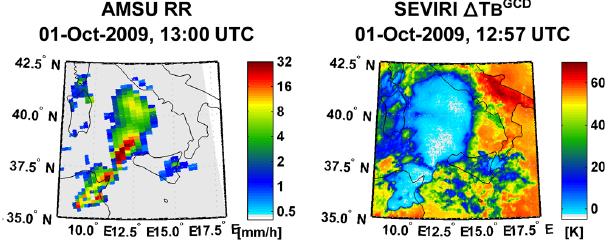
Fig. 1. AMSU/MHS rain-rate map from NOAA 18 with closest SE- VIRI GCD map from